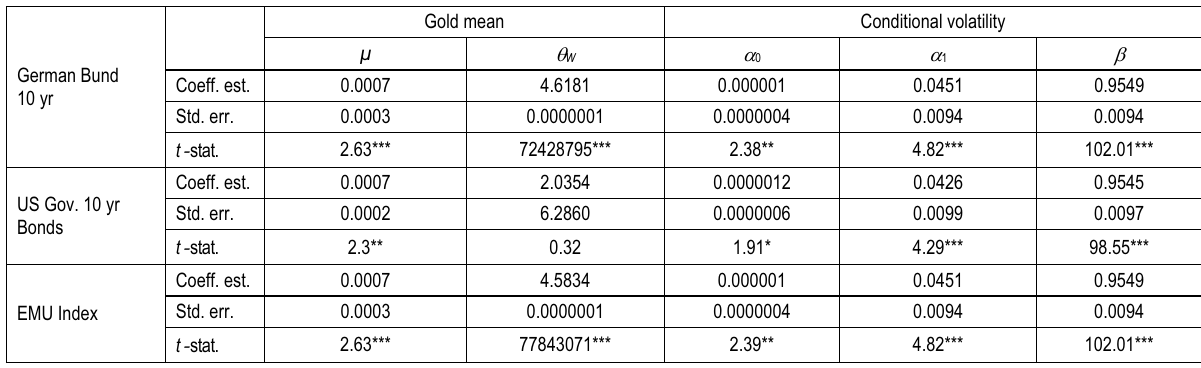
Table 7. Estimation results for government bonds